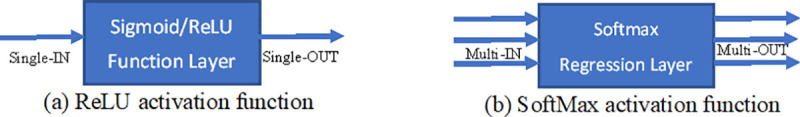
Different types of activation functions for classification.